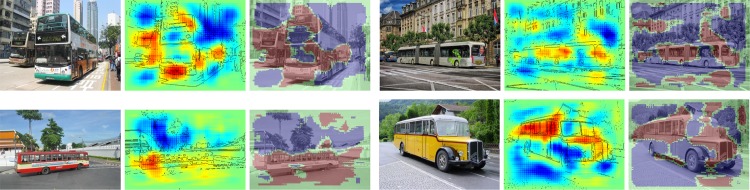
Pixel-wise decomposition for Bag of Words features over a histogram intersection kernel using the layer-wise relevance propagation for all subsequent layers and rank-mapping for mapping local features.Each triplet of images shows—from left to right—the original image, the pixel-wise predictions superimposed with prominent edges from the input image and the original image superimposed with binarized pixel-wise predictions. The decompositions were computed on the whole image. Images twice by Pixabay users tpsdave, and by Pixabay users sirocumo and Pixeleye.